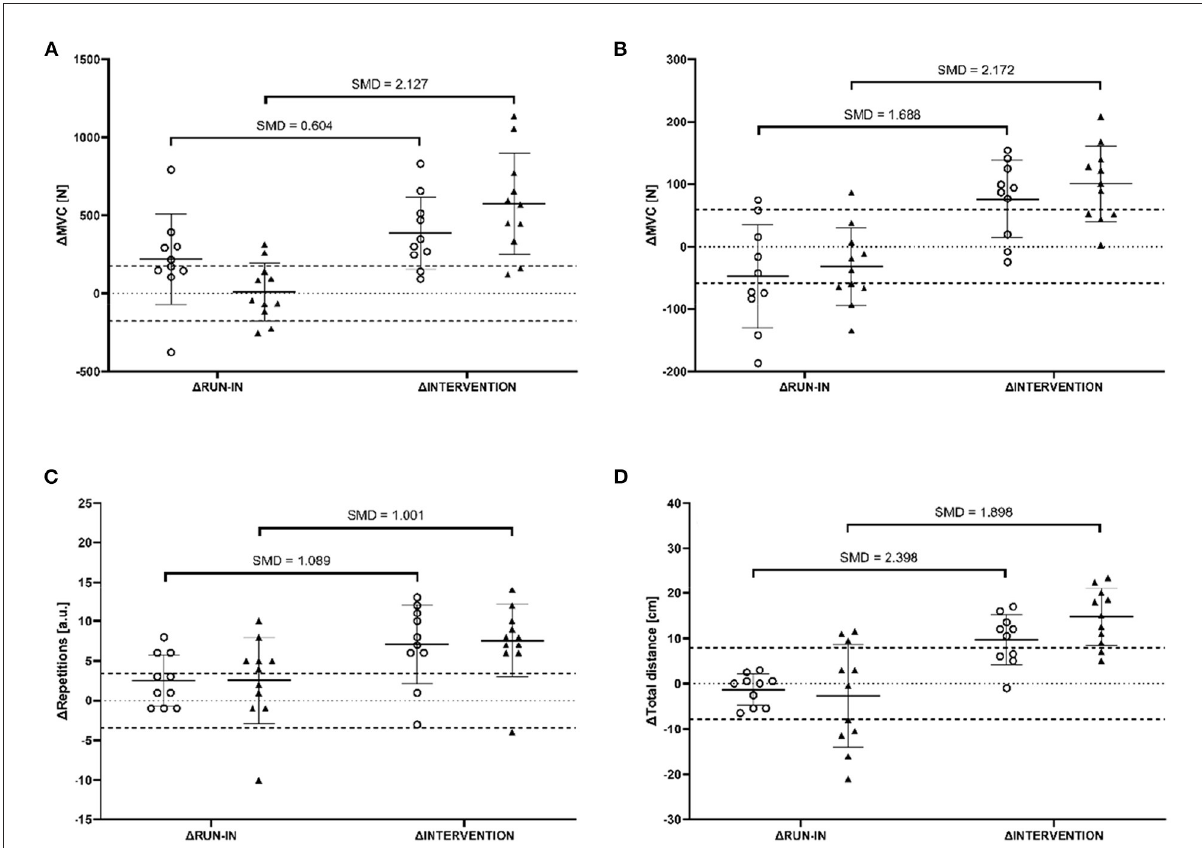
FIGURE2 The difference between BASELINE and PRE ( 1 RUN-IN) as well as PRE and POST ( 1 INTERVENTION) of maximal voluntary contraction (MVC) of leg press machine (A) , MVC of abdominal press machine (B) , repetitions of one-minute-sit-to-stand (C) , and the reach distance of Y-Balance-test (D) for all participants of the cluster training group (circles) and traditional training group (triangles). Dashed horizontal lines indicate the smallest worthwhile change [30% of the populations’ standard deviation at BASELINE (Hopkins, 2004)]. Further, mean values and standard deviations as well as standardized mean differences (SMD) are